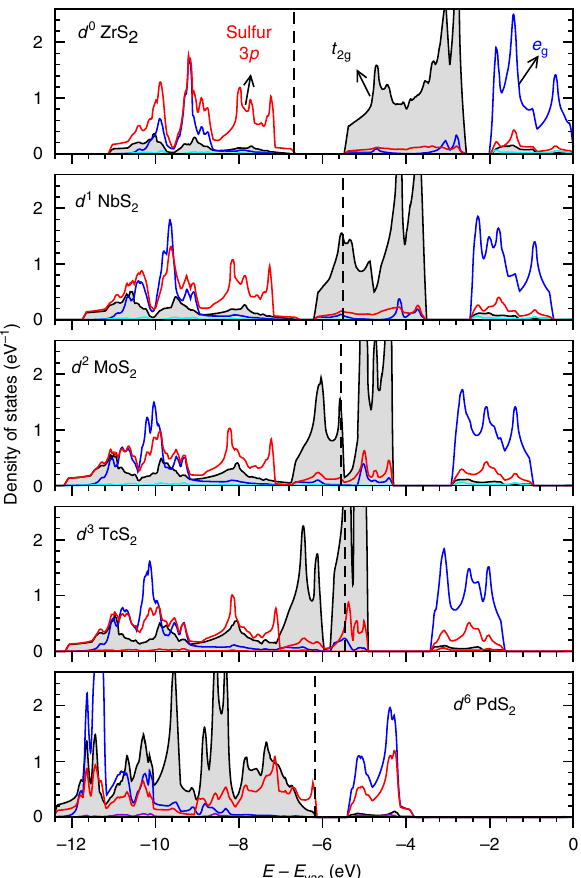
Figure 3 | DOS of 4 d MS 2 in the ideal 1T structure. The t 2g -p orbital coupling manifests itself in the overlap of their DOS. The local reference frame in the octahedral is used for projecting DOS. The DOS shown in the figure are t 2g ¼ d xy þ d yz þ d zx , e g ¼ d x 2 (cid:2) y 2 þ d z 2 and p ¼ p x þ p y þ p z . The vertical dashed lines show the position of Fermi level. The energy is aligned to the vacuum